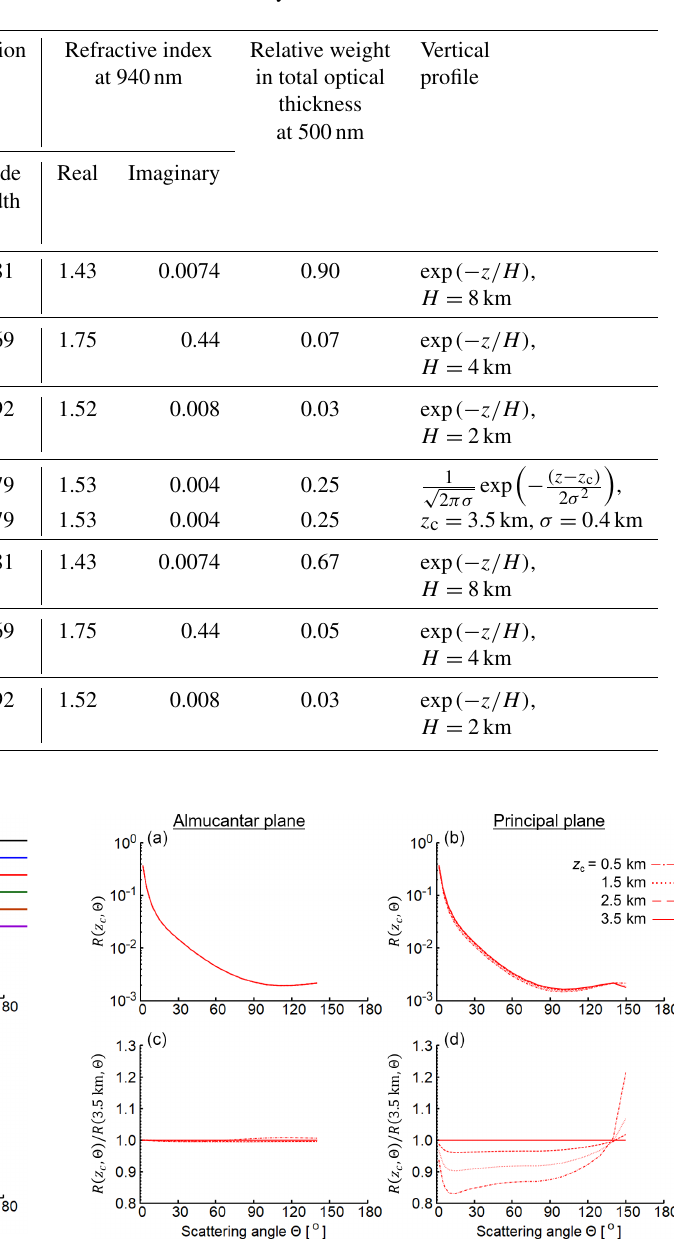
Figure 5. Similar to Fig. 4 but for SZA = 30 ◦ . Figure 6. Normalized angular distributions simulated for transported-dust aerosol (Table 2) in the almucantar and prin- cipal planes with an aerosol optical thickness of 0.06 at 940nm. Simulations were conducted for SZA = 70 ◦ and PWV = 2cm. The height of the dust layer ( z c ) is changed to 0.5, 1.5, 2.5, and 3.5km. The top row is the normalized radiance R(z c ,(cid:50)) , and the bottom row is the ratio of R(z c ,(cid:50)) to R( 3 . 5km ,(cid:50)) .